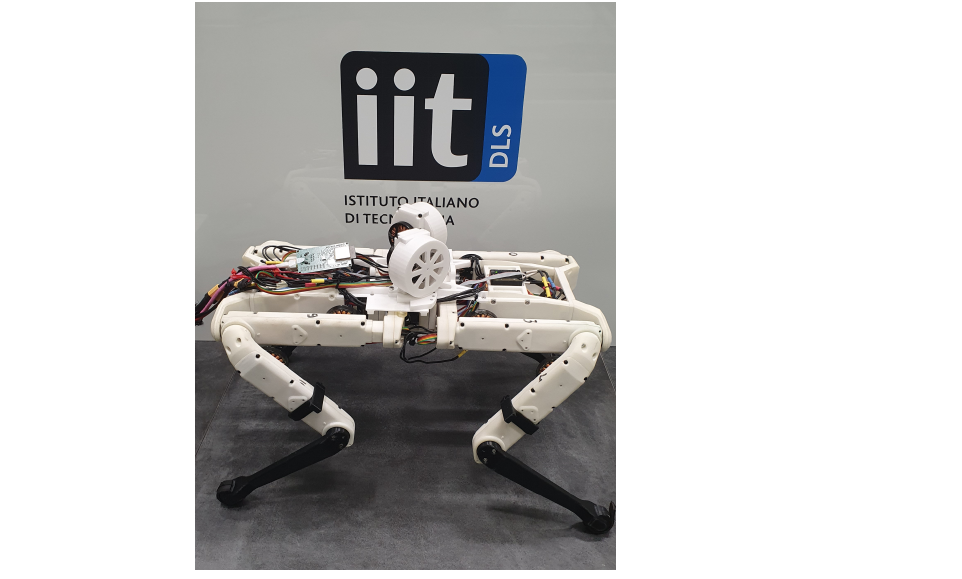
Figure 1. The proposed Orientation Control System for for the 2.5 kg quadruped robot Solo12 consists of two 0.1 kg flywheels with incident rotation axes. Each wheel is located in a 3D-printed shell and mounted on the trunk of the